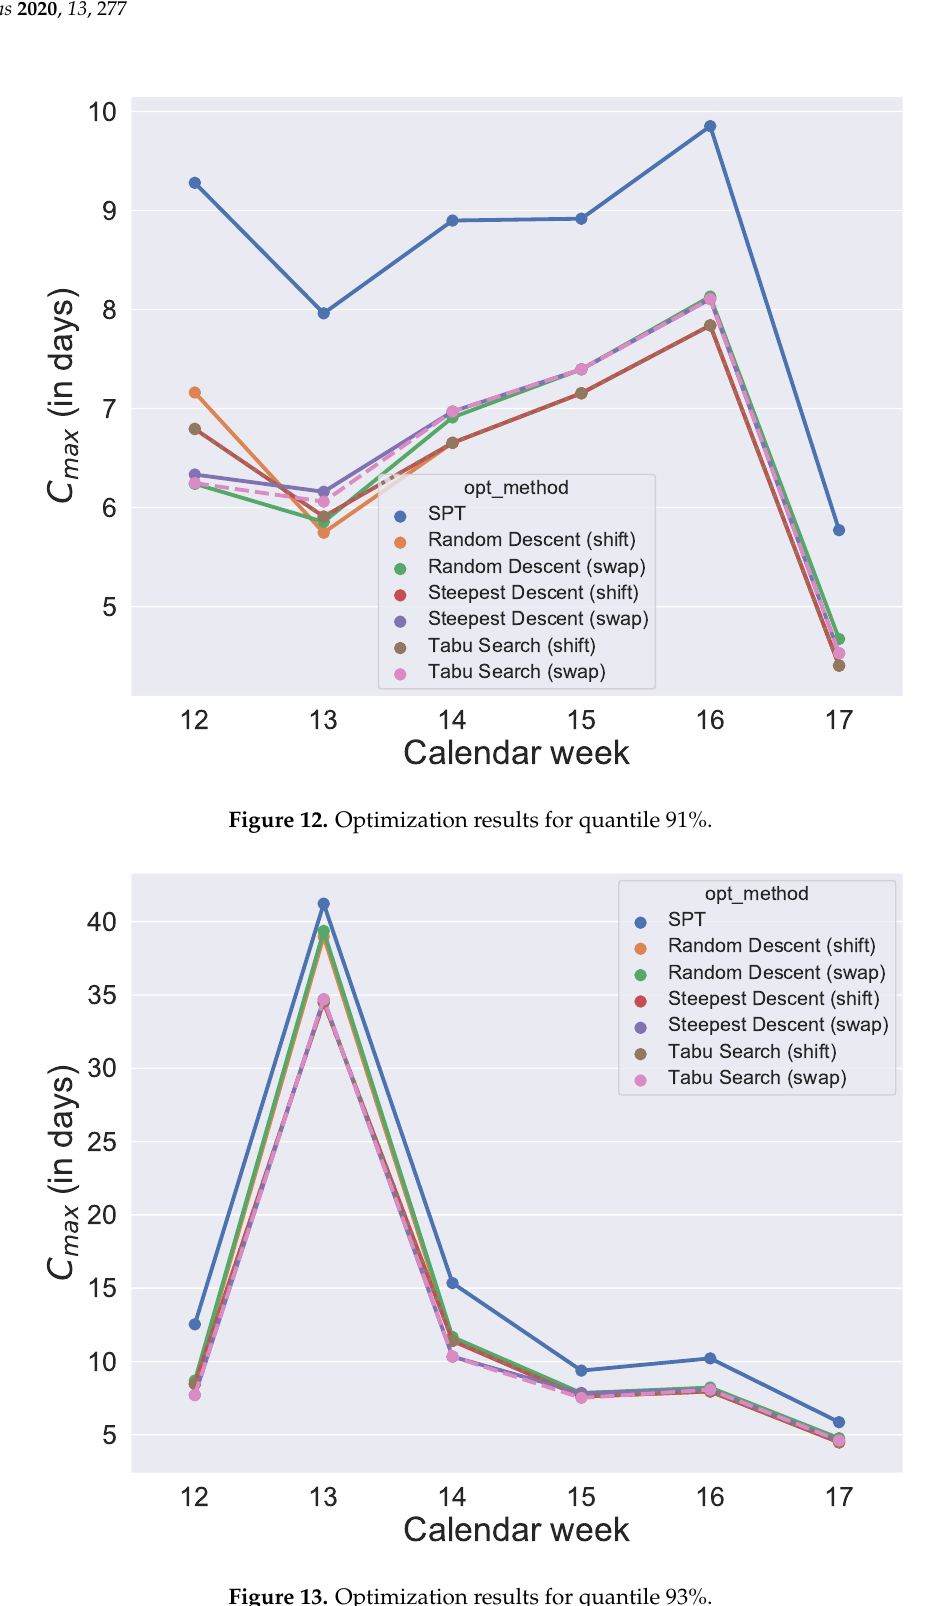
Figure 13. Optimization results for quantile